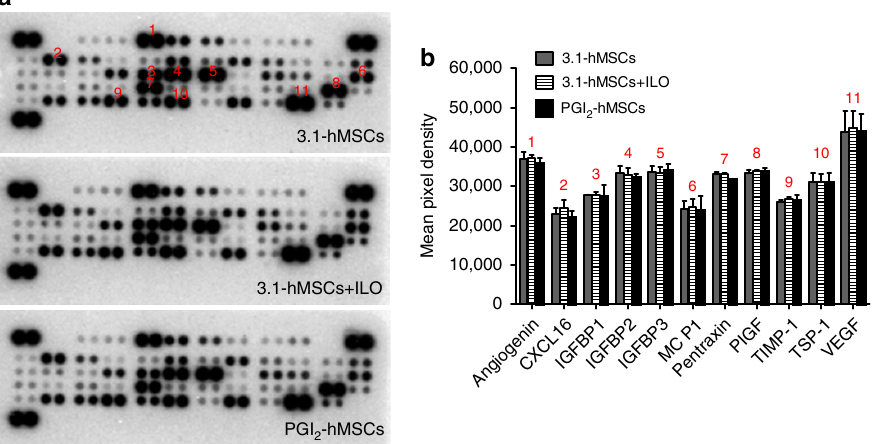
Figure 6 | PGI 2 -hMSCs did not affect the natural ability of hMSCs to release pro-survival and pro-angiogenic factors under hypoxia. ( a ) Representative images of proteome profiler arrays probed with 3.1-hMSC-conditioned medium (CM), 3.1-hMSCs þ ILO-CM, or PGI 2 -hMSC-CM. ( b ) Analysis of the differential expression of angiogenic factors and chemokines from three independent arrays. CM collected from 3.1-hMSCs, 3.1-hMSCs þ ILO or PGI 2 - hMSCs contained similar levels of soluble proteins known to promote survival and angiogenesis under ischaemic conditions. Data are shown as mean ± s.e.m. from three independent arrays. CXCL16, chemokine (C–X–C motif) ligand 16; IGFBP1-3, insulin-like growth factor-binding protein 1-3; MCP-1, monocyte chemoattractant protein-1; PIGF, placental growth factor; TIMP-1, TIMP metallopeptidase inhibitor 1; TSP-1, thrombospondin-1; VEGF, vascular endothelial growth